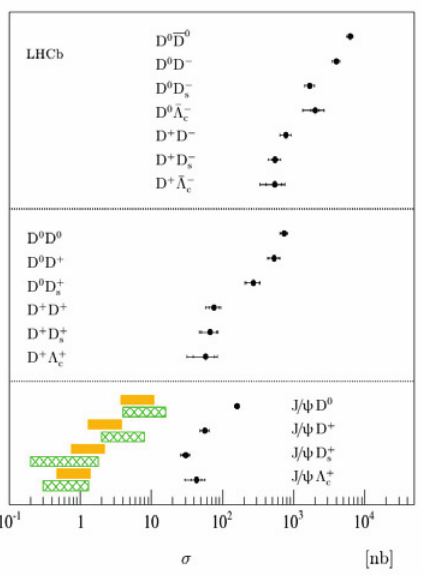
Figure 16. Measured cross-sections σ J /ψ C , σ CC and σ CC (points with error bars) compared, in J /ψ C channels, to the calculations in [25, 26] (hatched areas) and [27] (shaded areas). The inner error bars indicate the statistical uncertainty whilst the outer error bars indicate the sum of the statistical and systematic uncertainties in quadrature. Charge-conjugate modes are